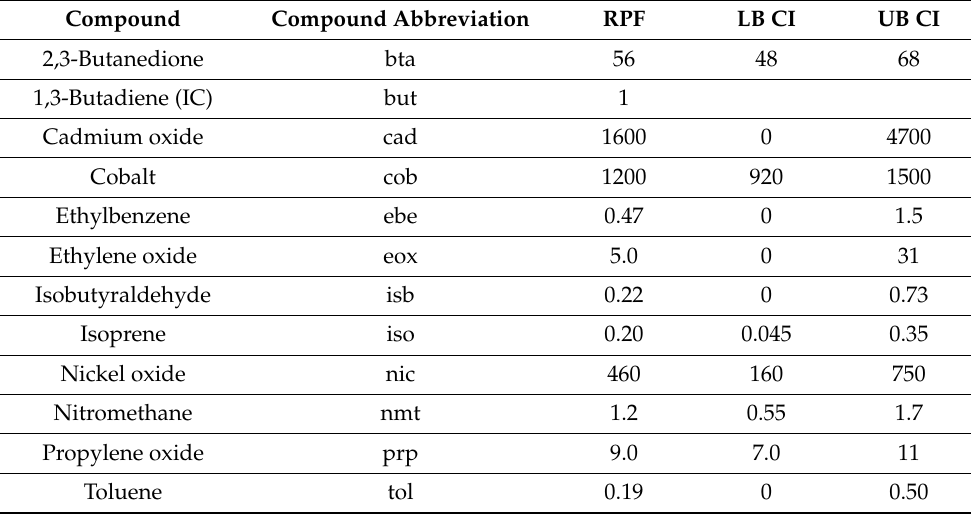
Table A3. Relative potency factors based on the decrease in body